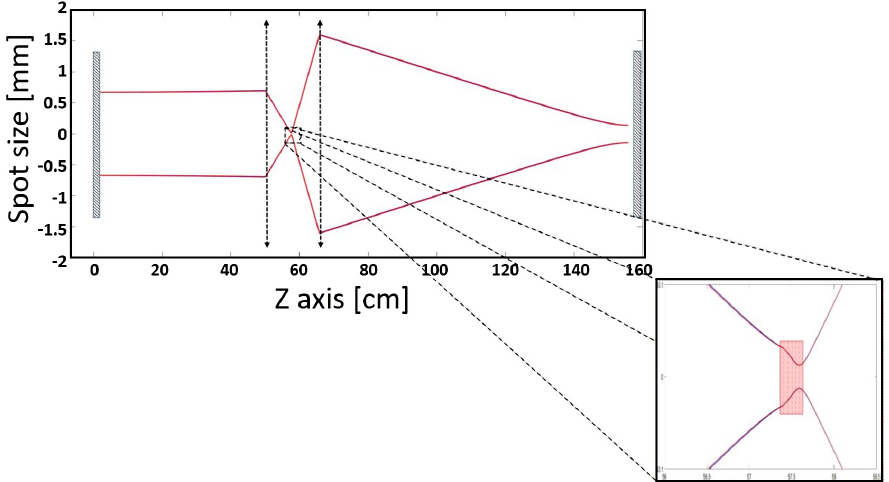
Figure 3. The beam propagation through the cavity in a representative round-trip. The non-linear focus bends the beam back into stable operation, creating an effective saturable absorber—low-power pulses are unstable, while high-power pulses are focused back into